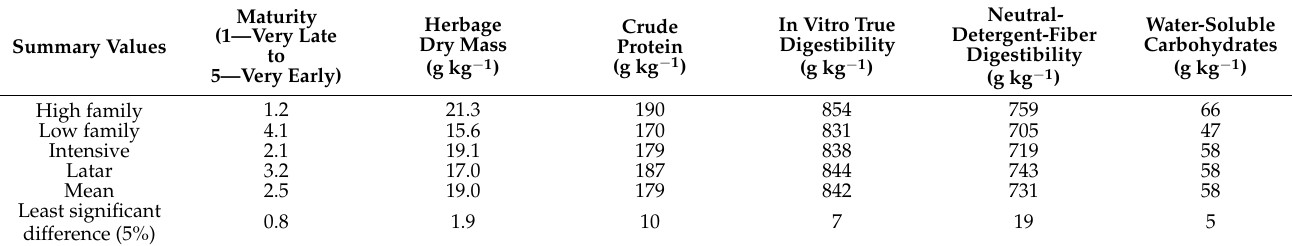
Table 3. Summary of mean experiment-wide values corresponding to 58 orchardgrass families and 5 commercial cultivars evaluated in 2013 and 2014 at Lewiston and Millville, UT under frequent and infrequent harvest frequencies. Values represent the family with the highest and lowest means for each trait, the means of cultivars Intensive and Latar, the overall trait mean, and the corresponding least significant